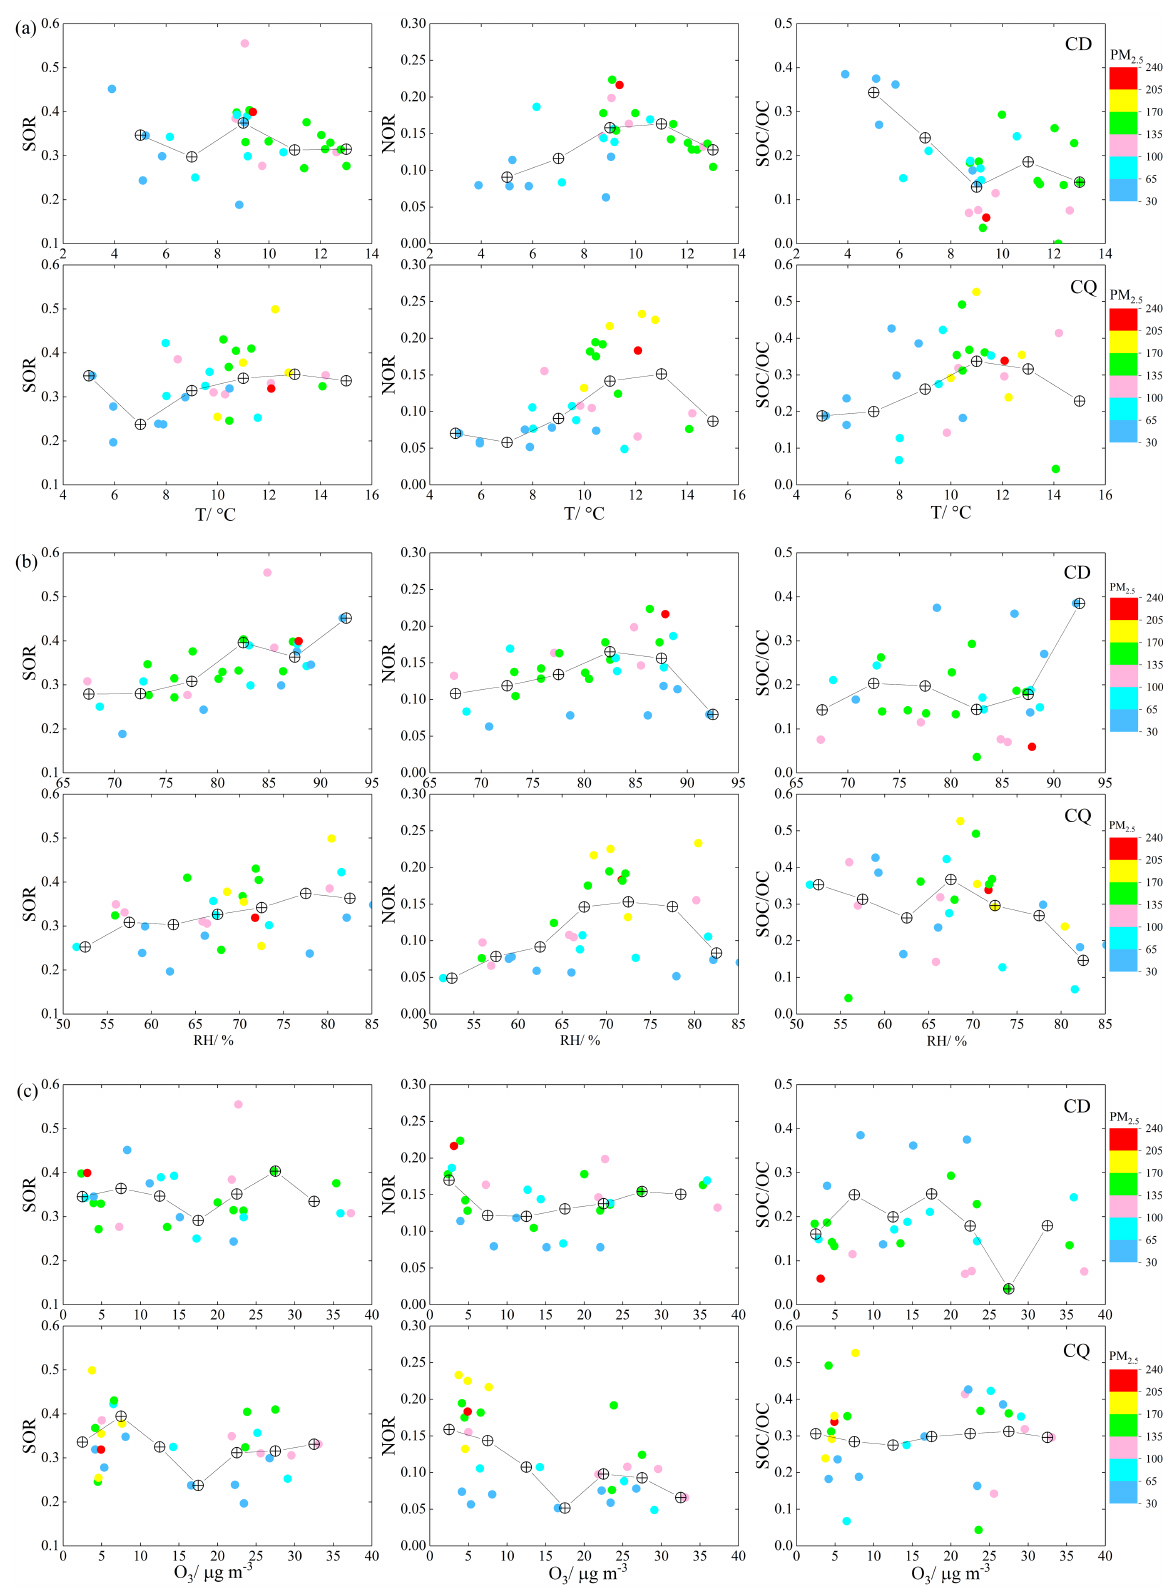
Figure 8. Correlations of SOR, NOR, and SOC / OC against temperature (a) , RH (b) , and O 3 concentration (c) in winter at CD and CQ.